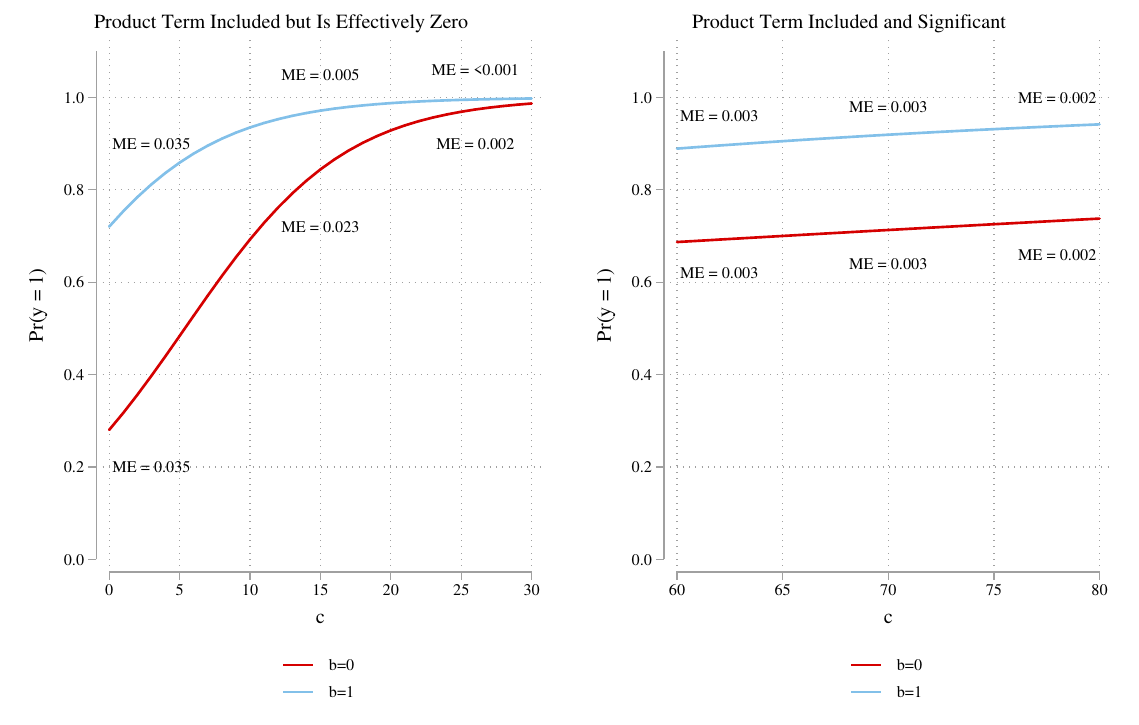
Figure 10: Interaction effect on the predicted probabilities cannot be determined by examining the coefficient of the product